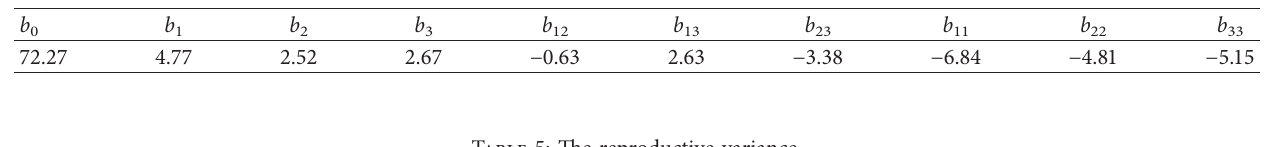
Table 4: The results of the regression coefficients.